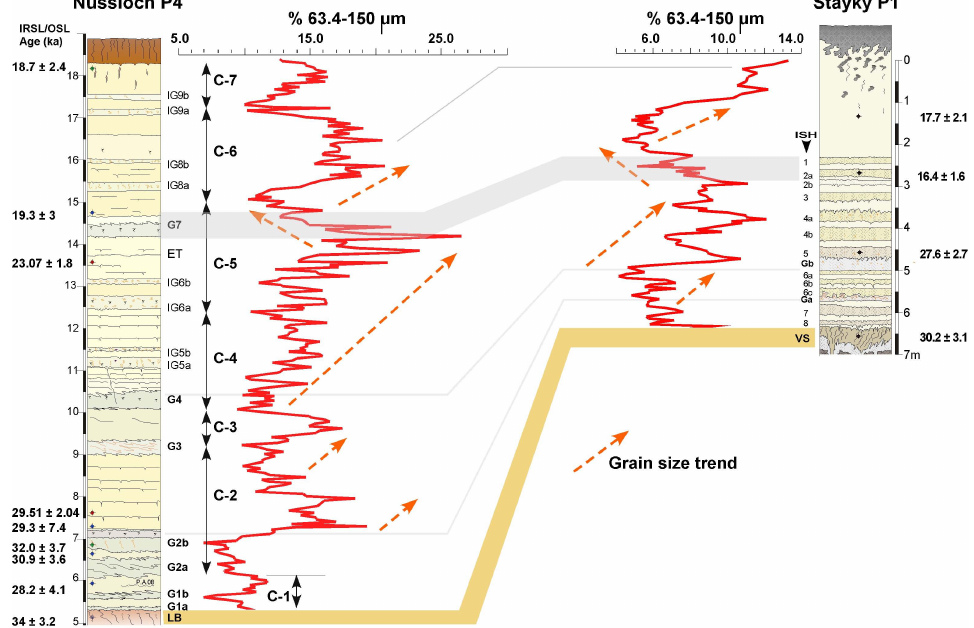
Fig. 10. Comparison of the variation of the coarse grain size fraction (% 63.4–150µm) in Stayky and Nussloch reference sequence (from Antoine et al.,